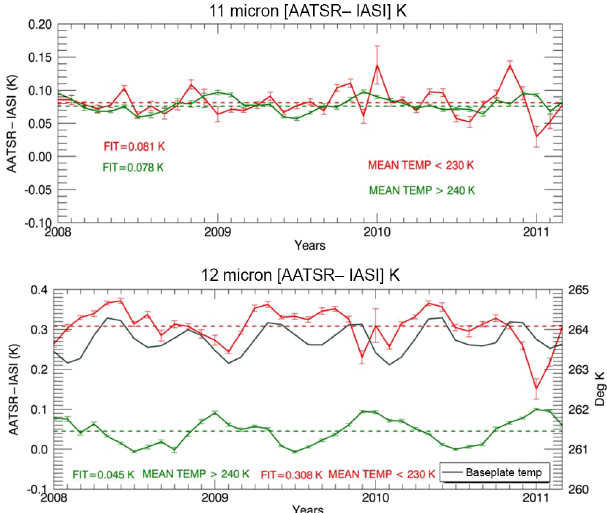
Figure 6. Time series of variation of AATSR–IASI bias for 11 and 12µm channels in the cold (red) and warm (green) temper- ature ranges. The bias at cold temperature in 12µm is correlated ( ρ = 0 . 78) with the instrument baseplate temperature (grey curve in the lower